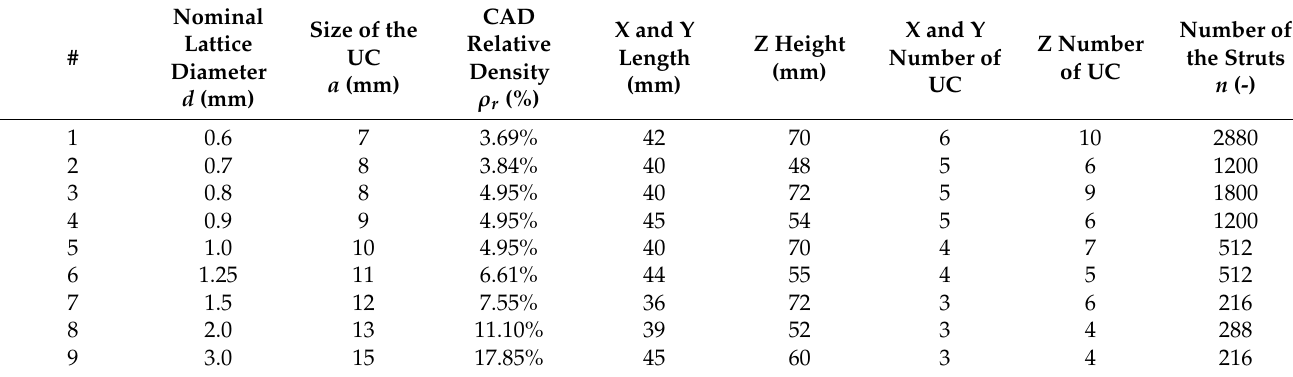
Table 1. The parameters of the BCC lattice structure batch.